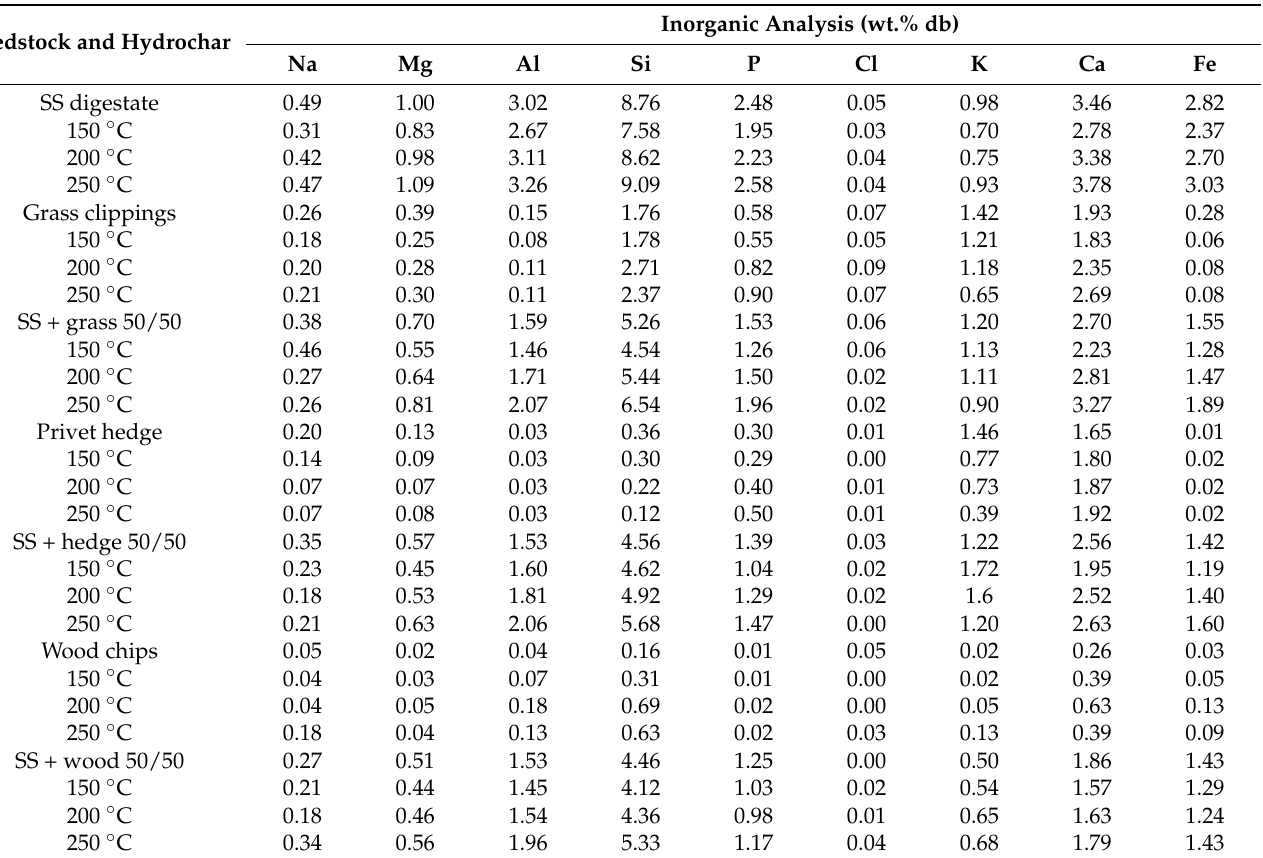
Table 5. Inorganic content of feedstock and 20% solid loading hydrochar from SS digestate,